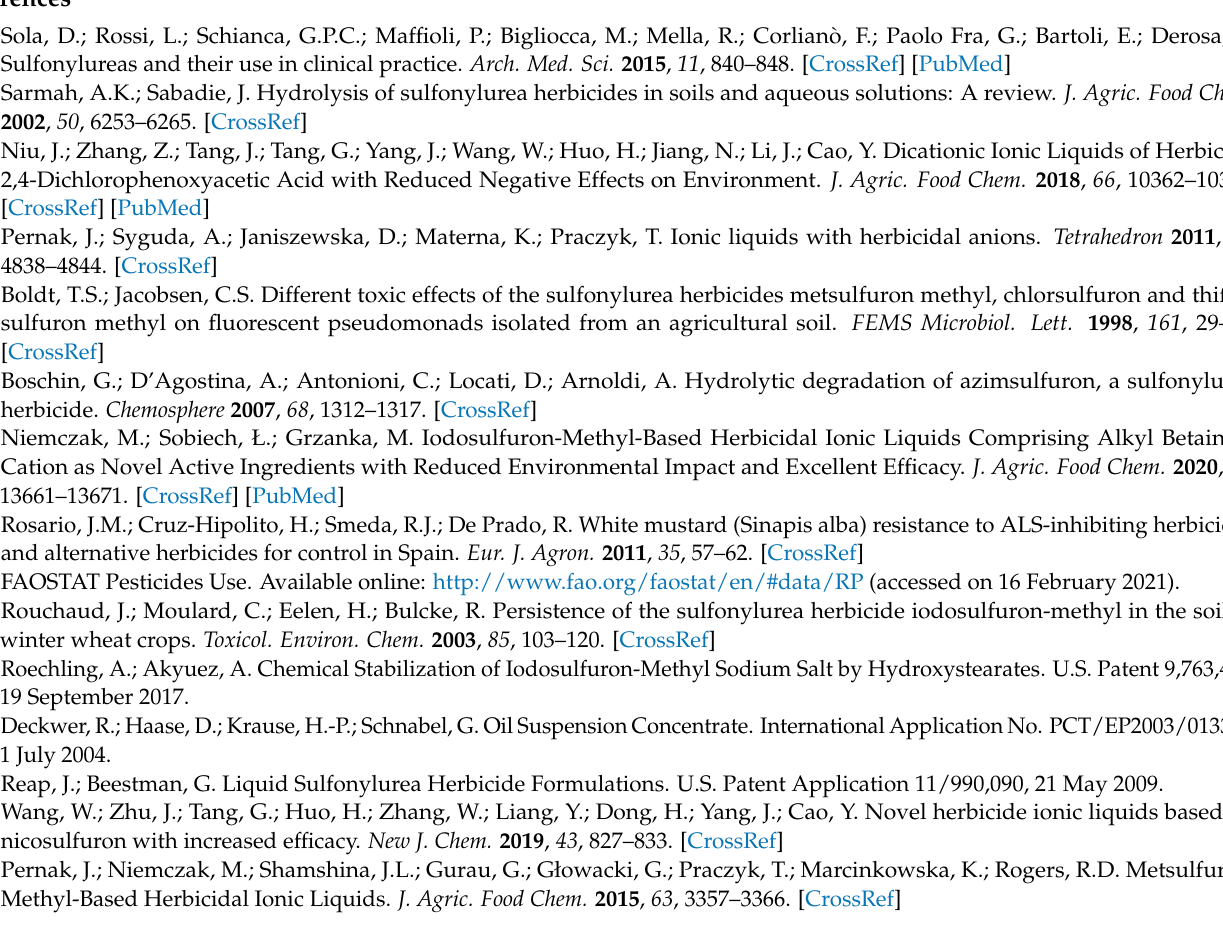
environment. Table S6. Volatility of the studied compounds at 35 ◦ C. Table S7. Efficacy of the prepared ILs (1–8) toward cornflower ( Centaurea cyanus L.) and oil-seed rape ( Brassica napus L.) Table S8. Migration of HILs in agricultural soil (soil TLC